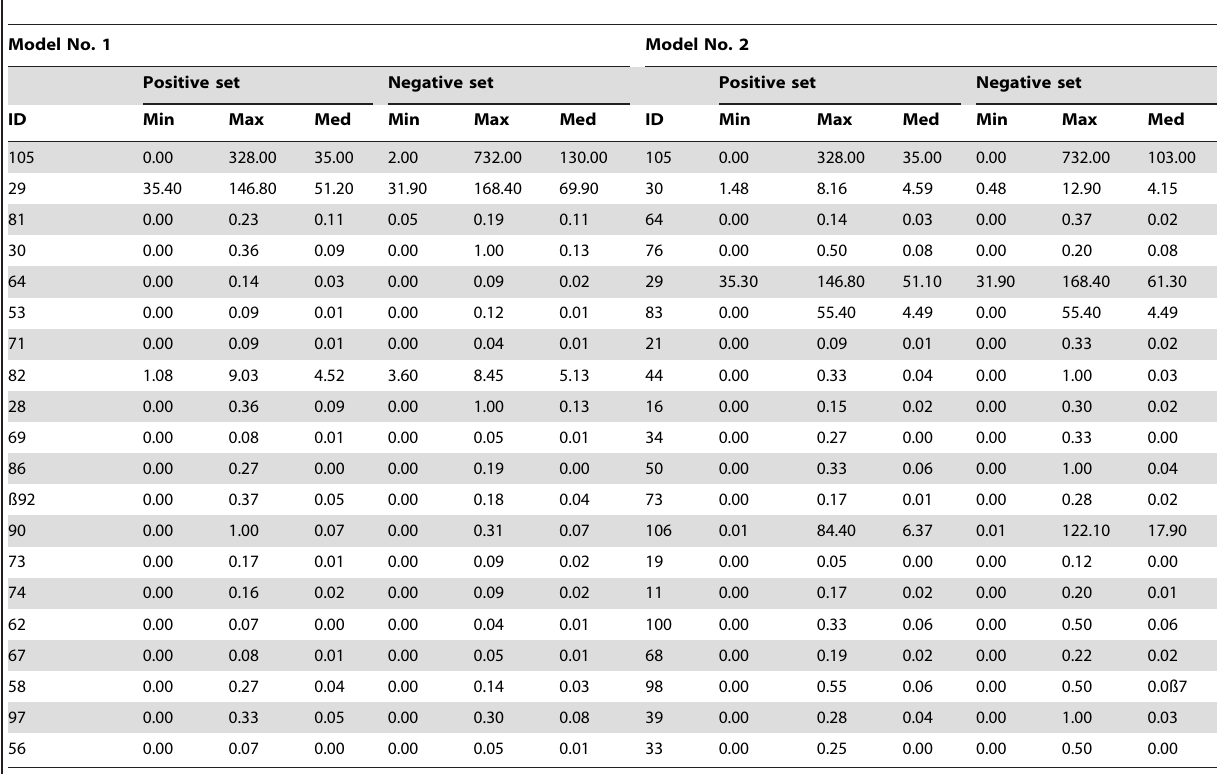
Table 5. Minimum, Maximum, and Median of feature values for top 20 ranked features for both SVM models.